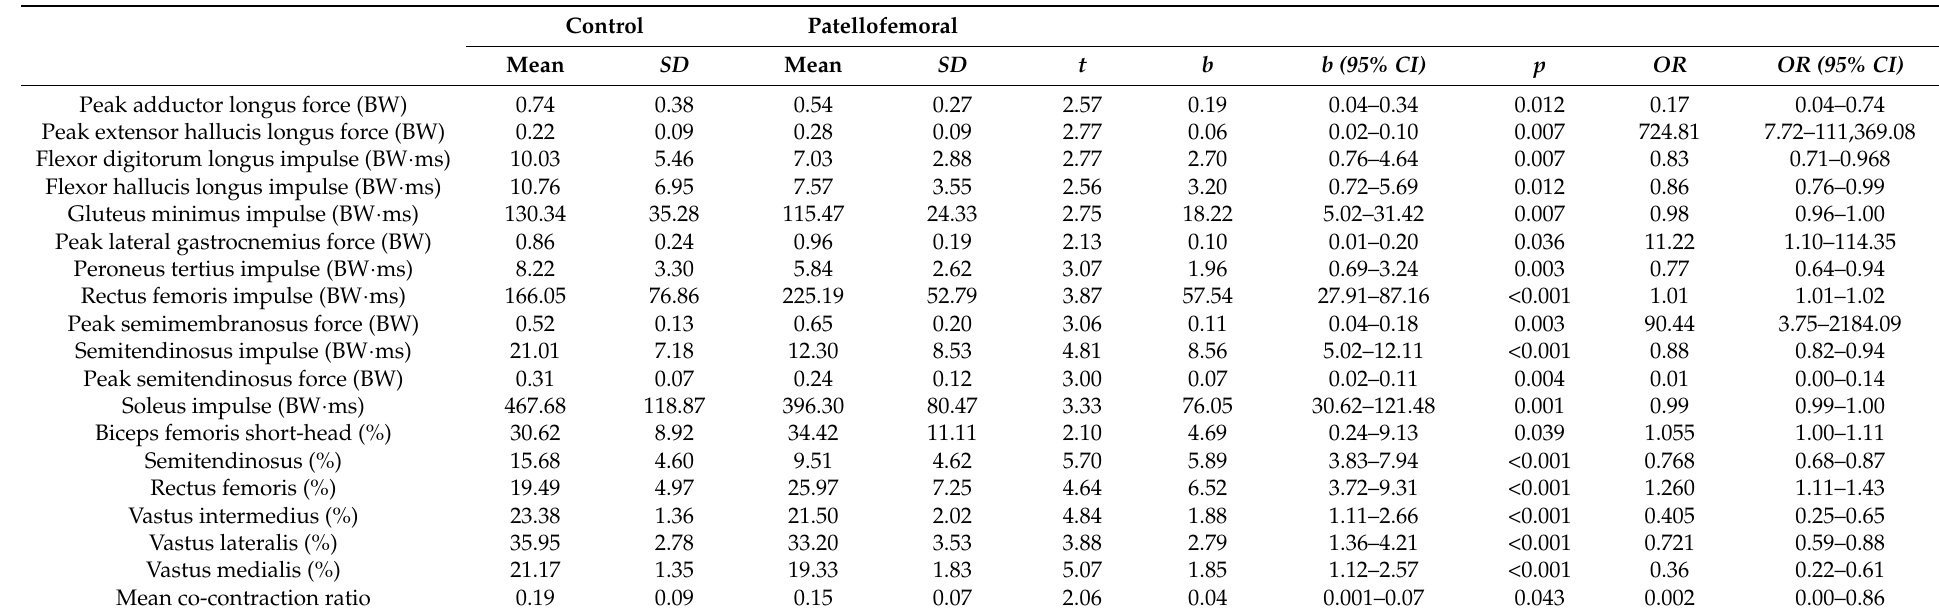
Table 4. Muscle force indices in overall PFP participants and